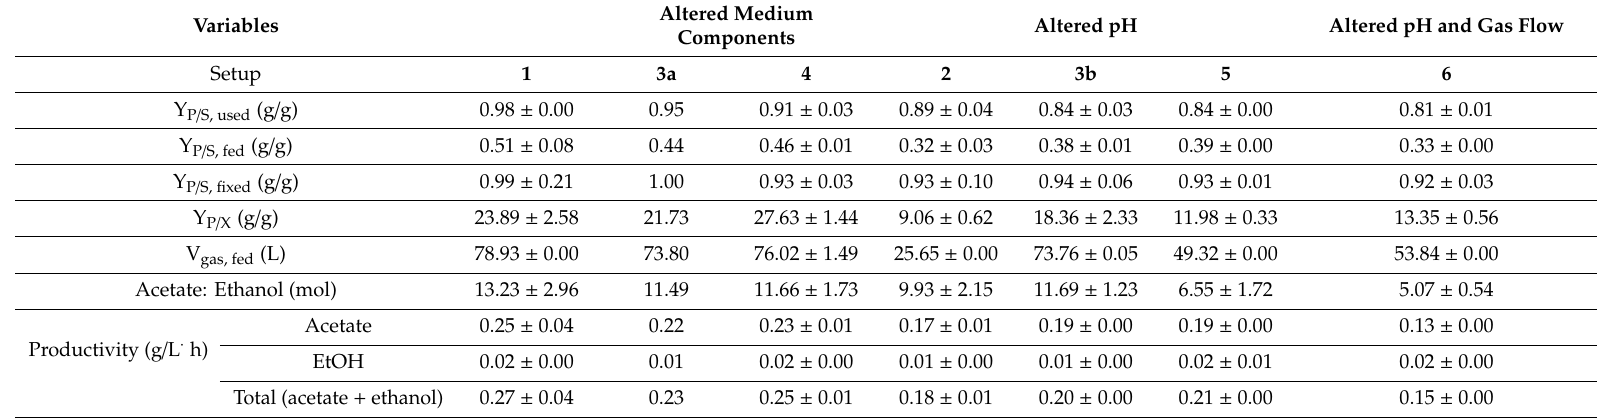
Table 4. Fermentation outcomes, yields, and productivities calculated up to the point when maximum CO fixation stopped. Setup 3a refers to the fermenter where pH was not altered and Setup 3b refers to the pair of fermenters where the pH was changed after 68 h to 5.4. Y P / S, (g / g) = gram of products (acetate and ethanol) formed per gram of substrate. Y P / X (g / g) = gram of product (acetate and ethanol) per gram of biomass (cell dry weight). Values are given as the average of a triplicate ( n = 3) with standard deviations, except for Setup 3a, where only the values for the fermenter left unaltered at pH 5.9 are shown, and Setup 3b, where the average of the two fermenters on which pH was modified is